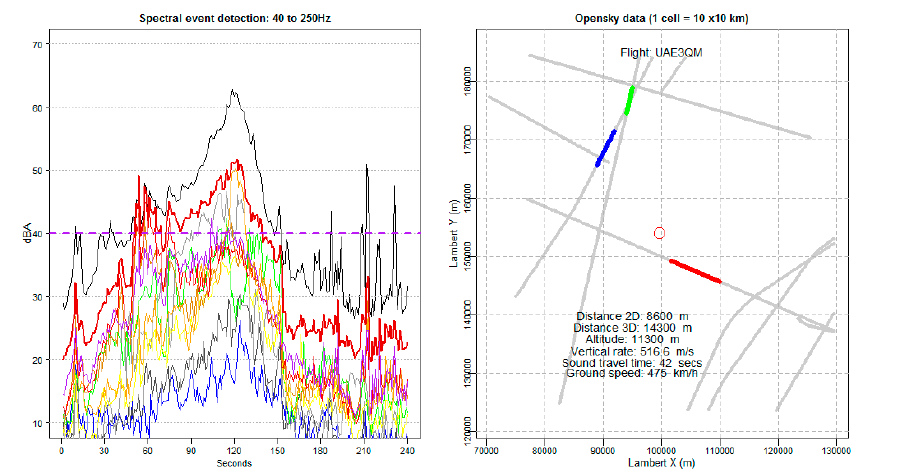
Figure 7. Colliding events ( left ) and flight data ( right ) for the L LF,T,e window and the MP box . The sound arrival time windows of three flights match the detector windows L LF,T,w and are highlighted in the flight